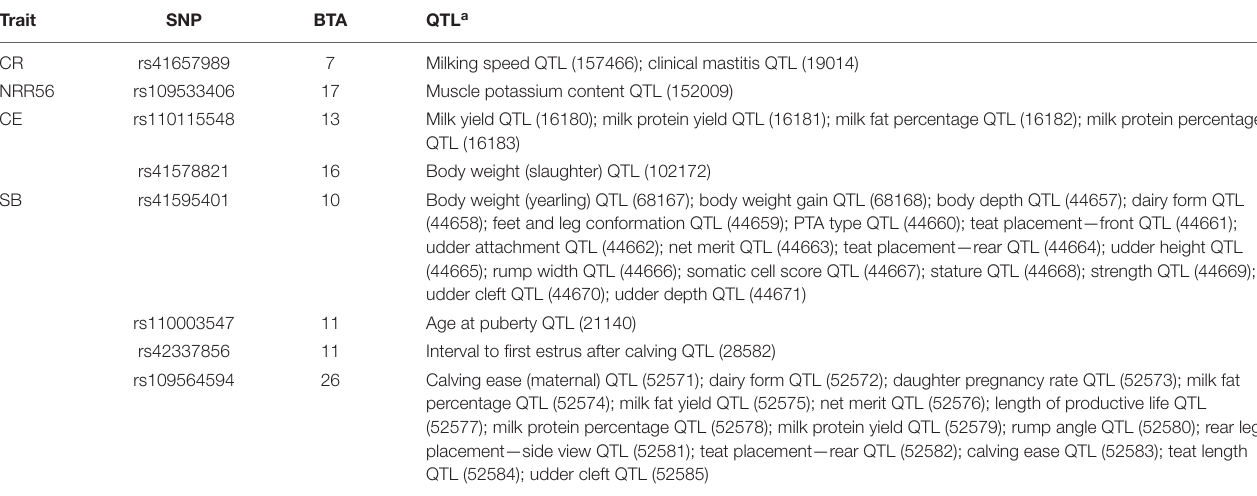
TABLE 7 | Significant single-nucleotide polymorphisms (SNPs) of the genetic effects of dam and overlapping quantitative trait loci (QTLs). Trait SNP BTA